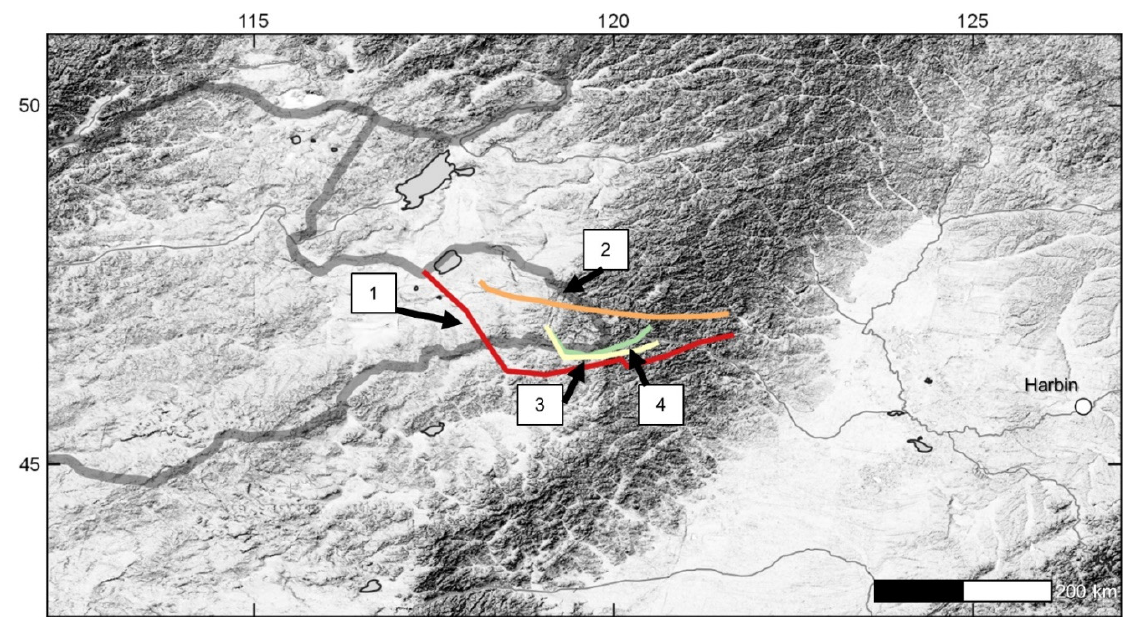
Figure 1. The location of the northern and southern lines of the Medieval Wall System. The southern line is the focus of this study. The locations of this wall are derived from Xie [26].